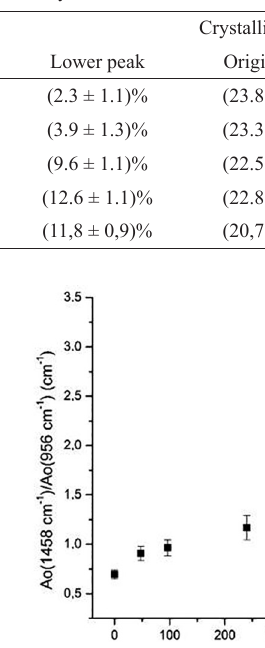
Table 3: Melting point and crystallinity degree of the samples measured by DSC.